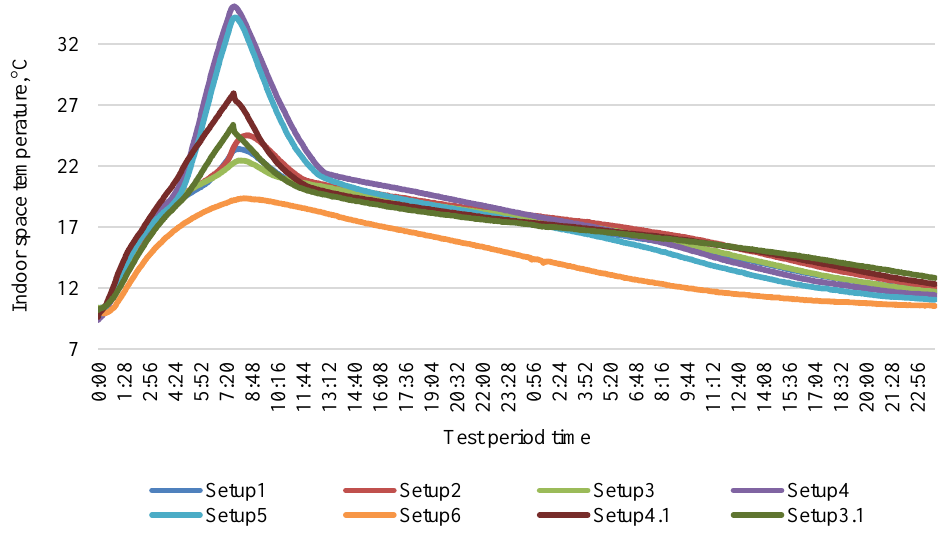
Fig. 7. Indoor space temperature in various